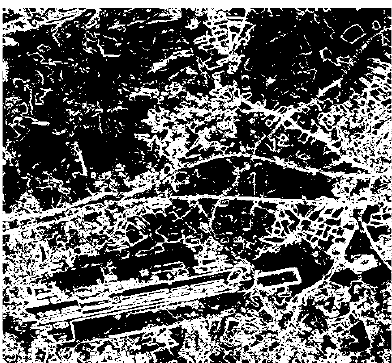
Figure 4: Binary version of R-band of Rasat test